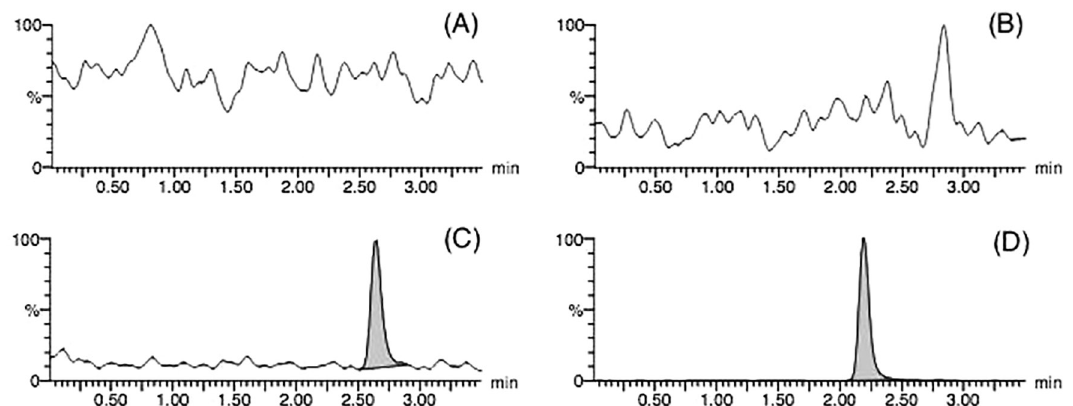
FIGURE 2 - Blank human plasma chromatograms m/z 419.3>199.0 (A); 405.0>199.0 (B) and a plasma sample spiked at the LLOQ (0.4 ng/mL) concentration m/z 419.3>199.0 (C); 405.0>199.0